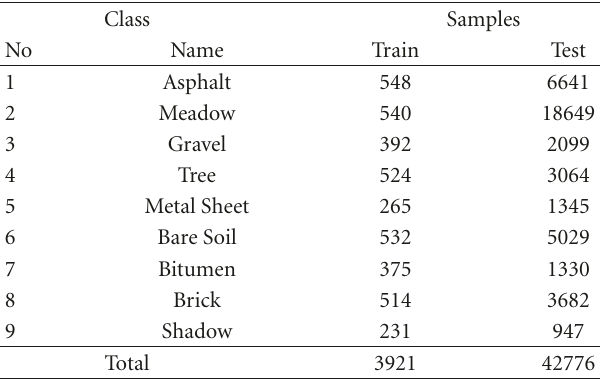
Table 1: Information classes and training/test samples for the University Area data set.